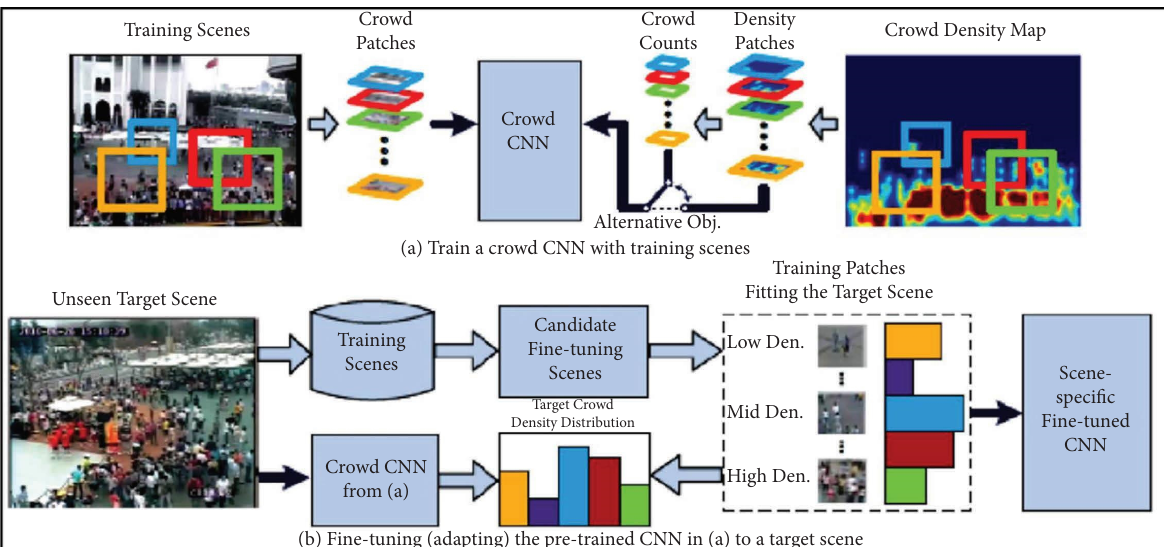
Figure 1: Te scheme that presents the Zhang et al. proposed approach [12].